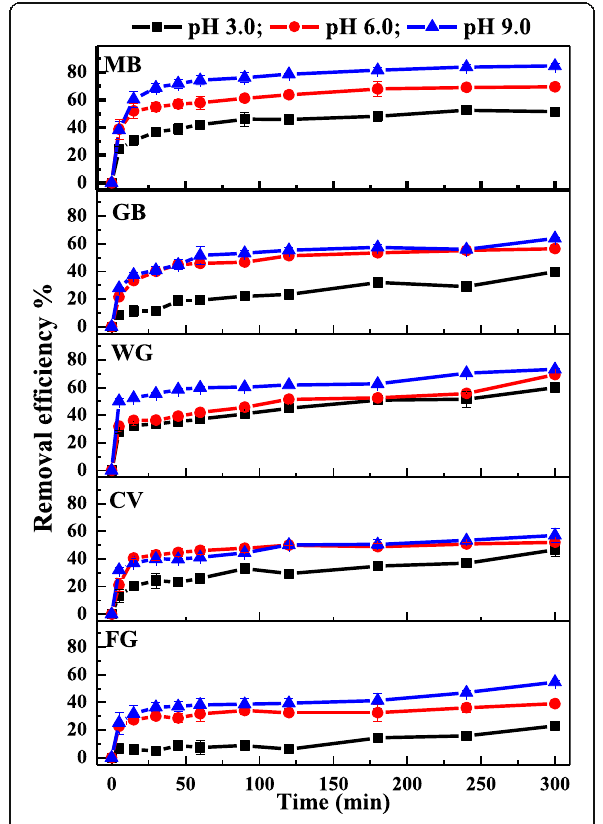
Fig. 7 Effect of initial pH on the removal of cationic dyes on Fe 3 O 4 /PCC MNPs the temperature is 30 °C. As shown as Fig. 7, the blank line represent that the solution pH is 3.0, the red line reperesent that the solution pH is 6.0, and the blue line represent that the solution pH is 9.0